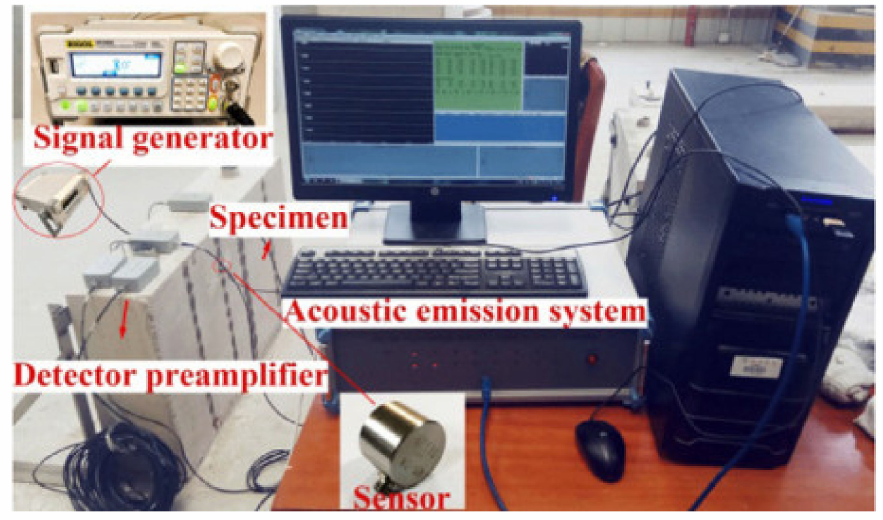
Figure 3. Acoustic emission system